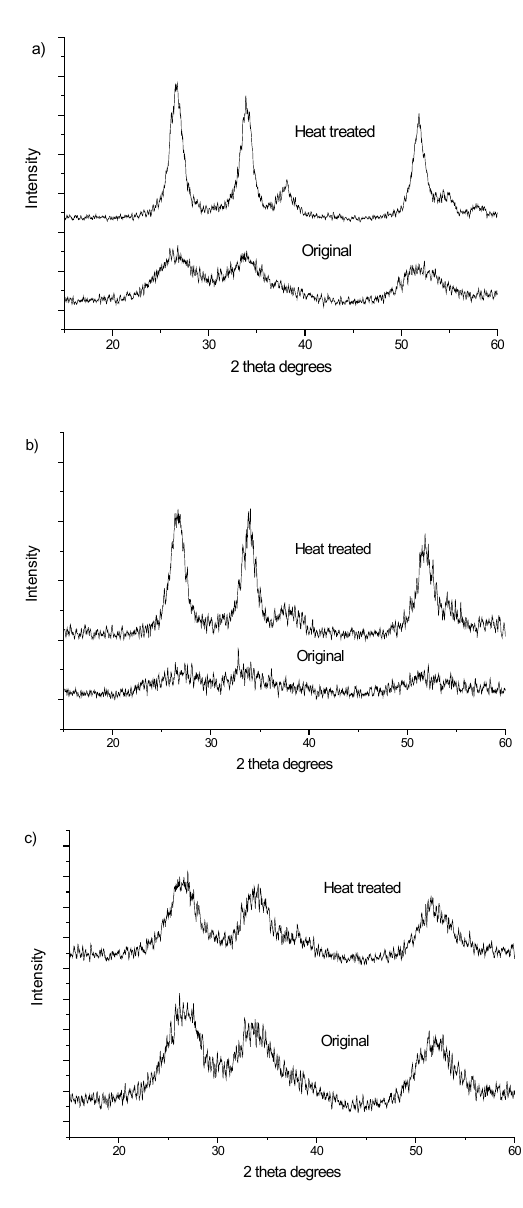
Figure 1. XRD diffractograms of a) tin dioxide and its analogous with b) Sb(III) and c) Sb(V) antimony doping. A material’s XRD diffractogram after heat treatment has also been added to the